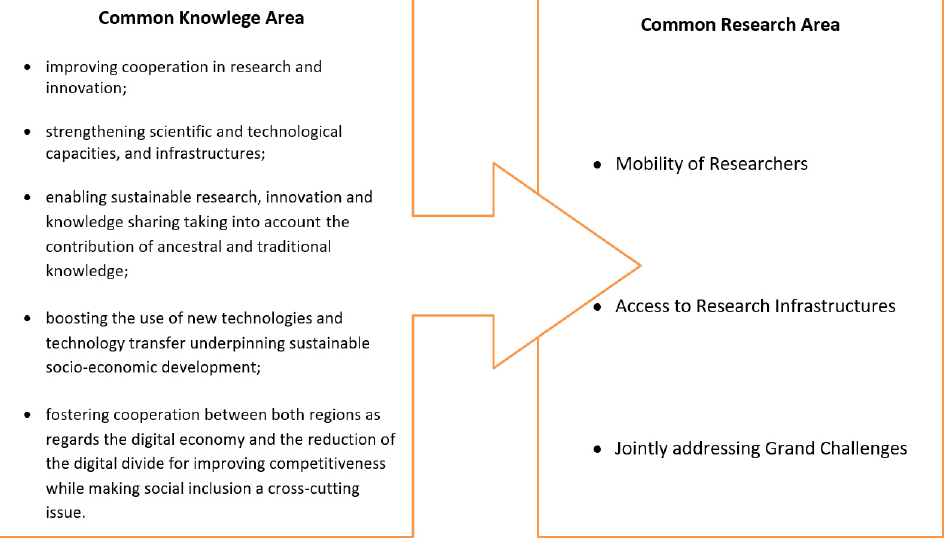
Figure 1. From the Common Knowledge Area to the Common Research Area.